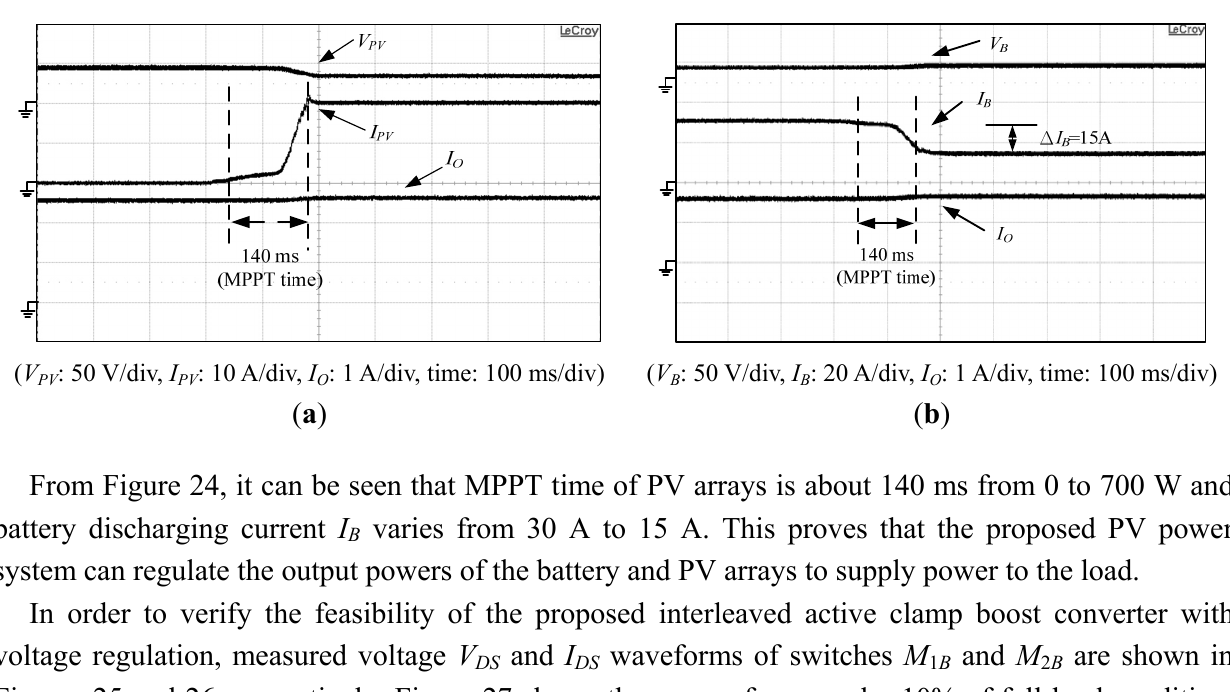
of 700 W: PV ( max ) waveforms; and ( b ) battery O